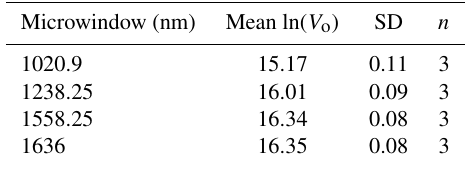
Table B1. Mean values of ln( V o ) from 14, 19, and 24 September 2020 used for deriving